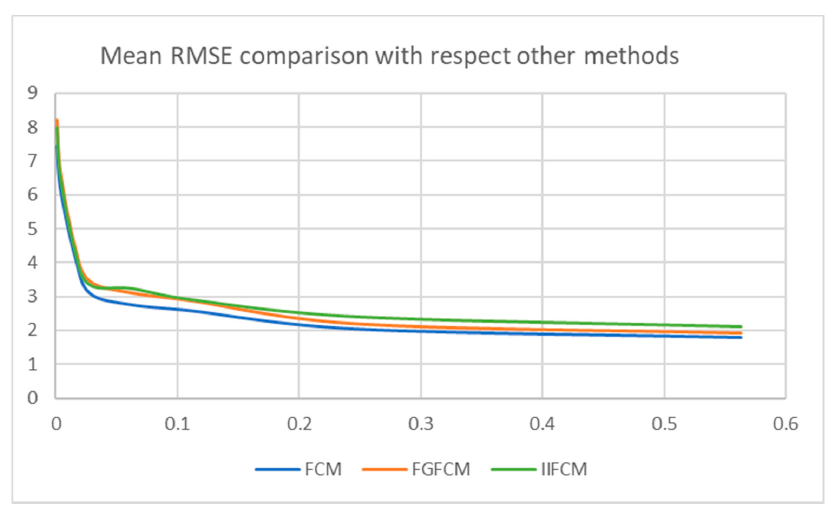
Figure 14. Mean RMSE trend with respect to FCM, fuzzy generalized fuzzy c-means (FGFCM) [16] and improved intuitionistic fuzzy c-means (IIFCM).